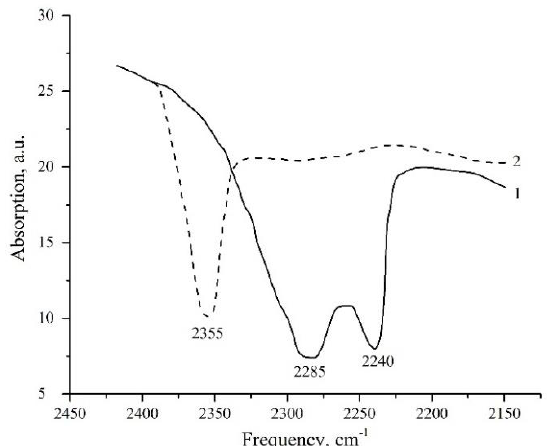
Figure 2. (1) IR spectra of N 2 O adsorbed at 300 K on Zn/HZSM-5; (2) IR spectra upon heating the Zn/HZSM-5 zeolite at 520 K for 1 h with pre-adsorbed N 2 O (300 K).